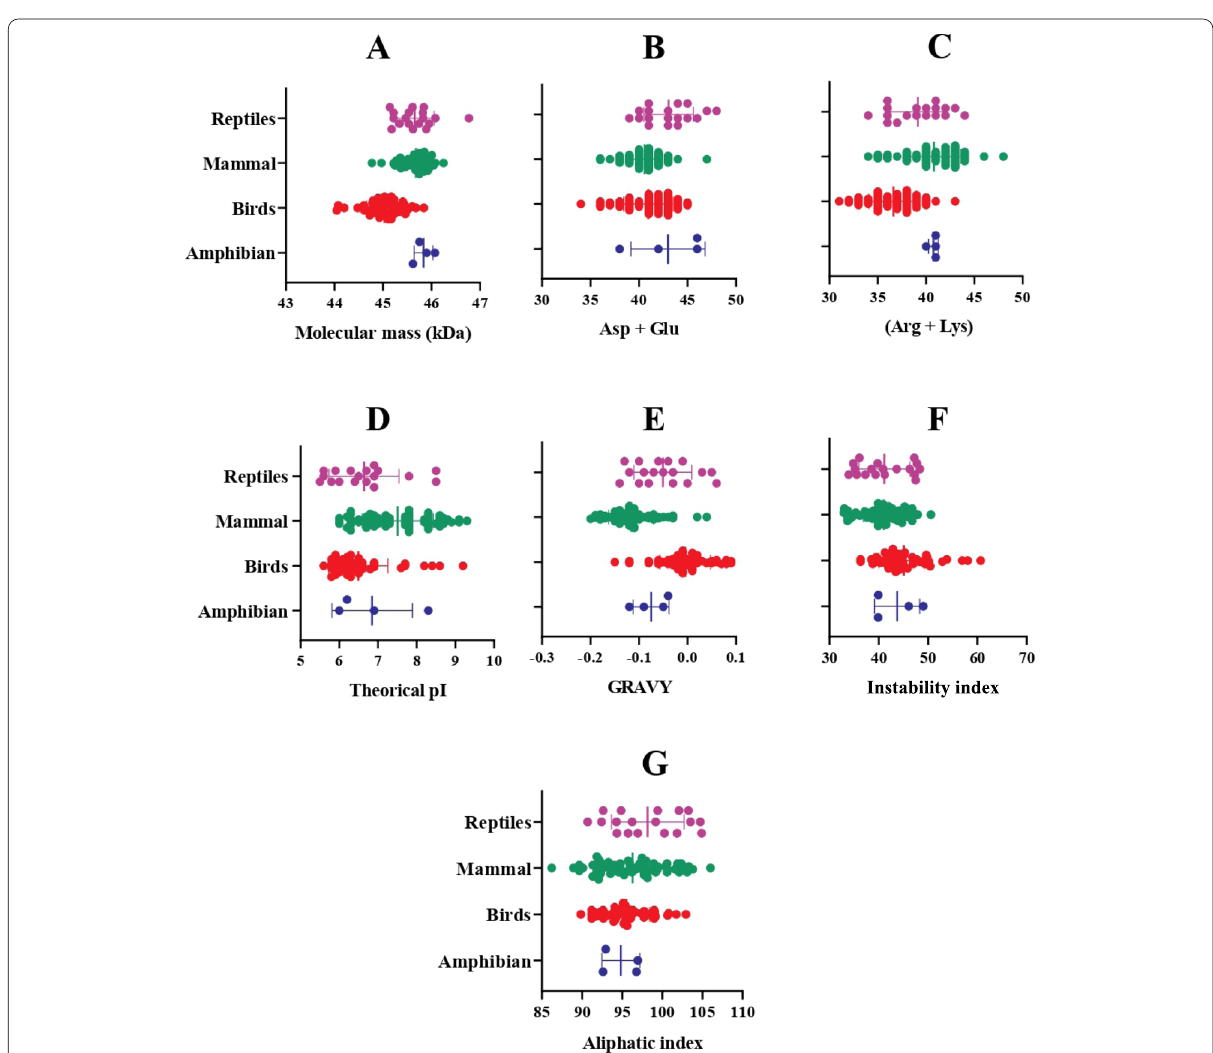
Fig. 7 Distribution plot depicting seven major predicted physicochemical properties of AADAC orthologues using the ProtParam Tool. A Molecular mass (kDa), B Percentage of negatively charged amino acids (Asp Glu), C Percentage of positively charged amino acids (Arg Lys), D Theoretical + + isoelectric point ( pI ), E Grand average of hydropathicity index (GRAVY), F Instability index, and G Aliphatic index. The complete computed physicochemical properties for each AADAC ortholog are depicted in Supplementary Table S1. One‑way non‑parametric ANOVA was used to evaluate significant differences between orthologues characteristics using GraphPad Prism version